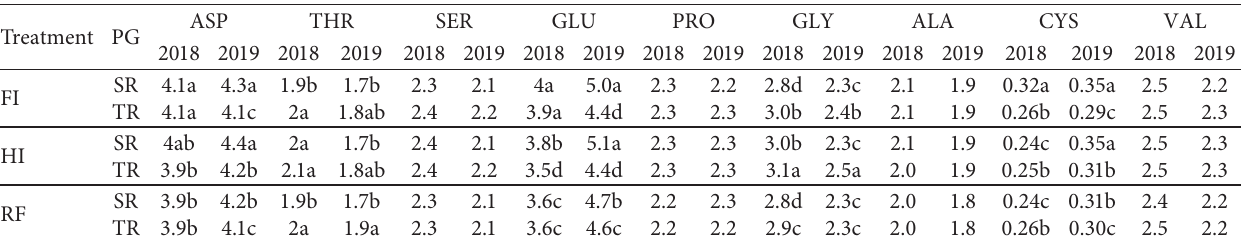
Table 6: Effect of irrigation treatments (FI, HI, and RF) and PG (SR and TR planting) on soybean seed amino acids: aspartic acid (ASP), threonine (THR), serine (SER), and glutamic (GLU), proline (PRO), glycine (GLY), alanine (ALA), cystine (CYS), valine (VAL), methionine (MET), isoleucine (ISO), leucine (LEU), tyrosine (TYR), phenylalanine (PHE), and lysine (LYC). ASP THR SER GLU PRO GLY ALA CYS VAL Treatment PG